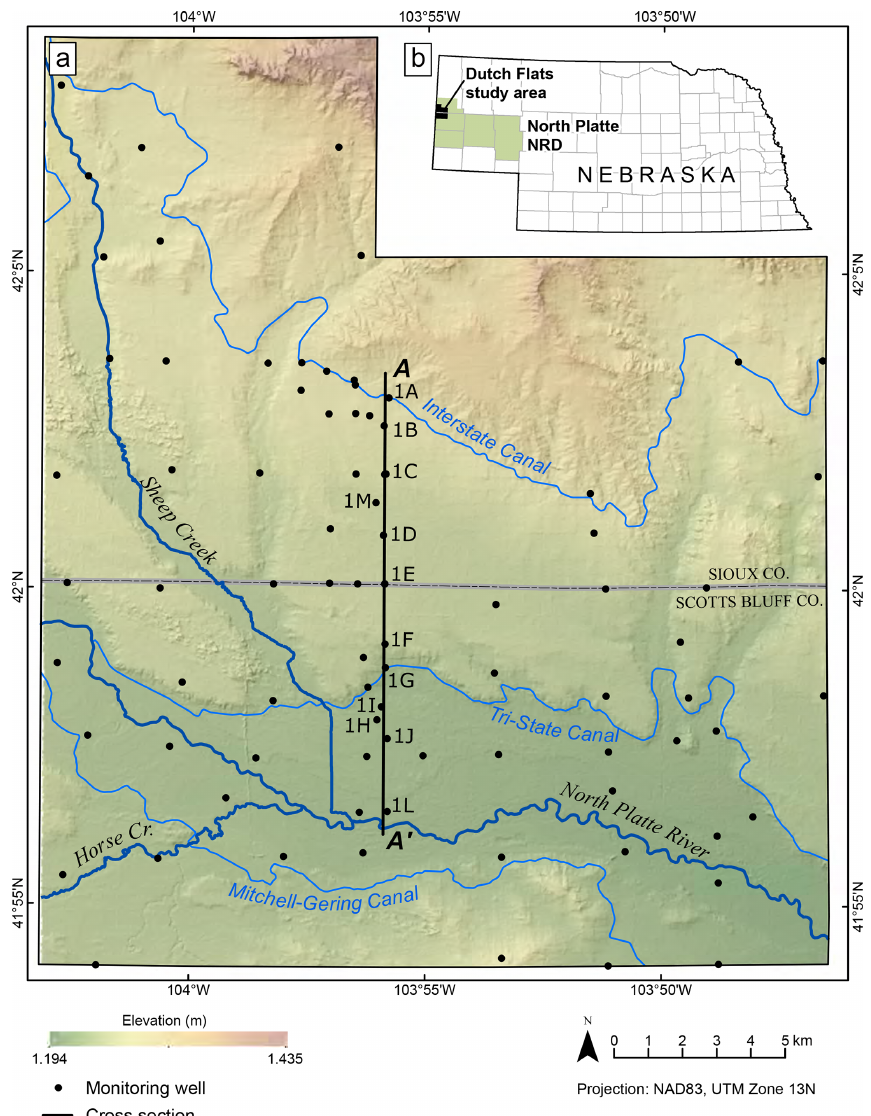
Figure 1. Dutch Flats study area (a) overlain by 30m digital elevation model (DEM; USGS, 1997). The study area is located within the North Platte Natural Resources District of western Nebraska (b) . Depending on data availability, multiple wells (well nest) or a single well may be found at each monitoring well location. Transect A–A (cid:48) represents the location and wells displayed in the Fig. 2 hydrogeologic cross